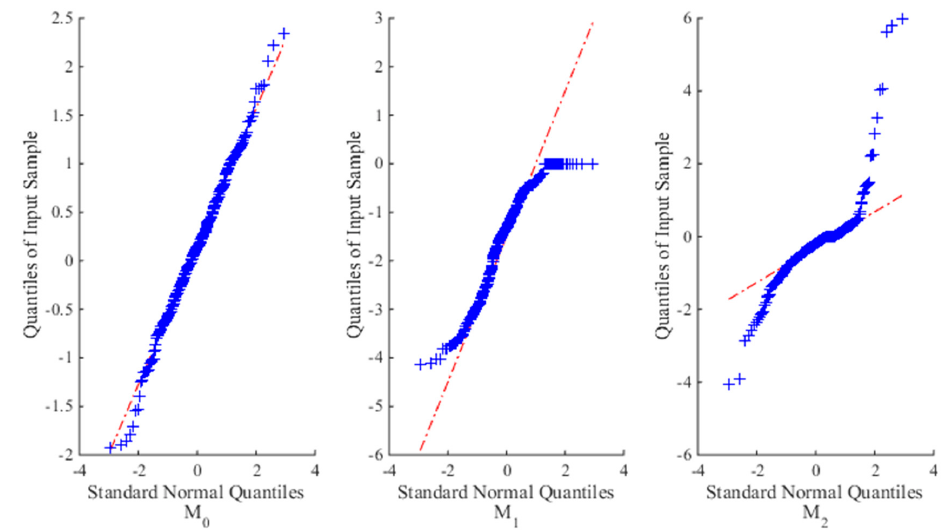
Figure 2. The Q-Q plots for three candidate models for the simulated SSADT data when n = 10.